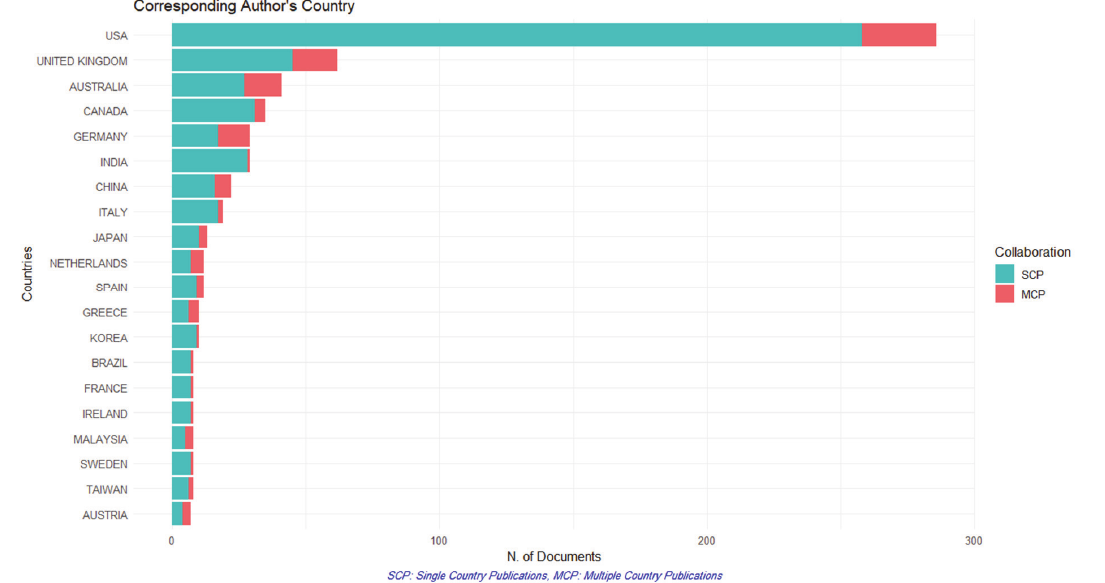
Fig. 7. Corresponding author’s